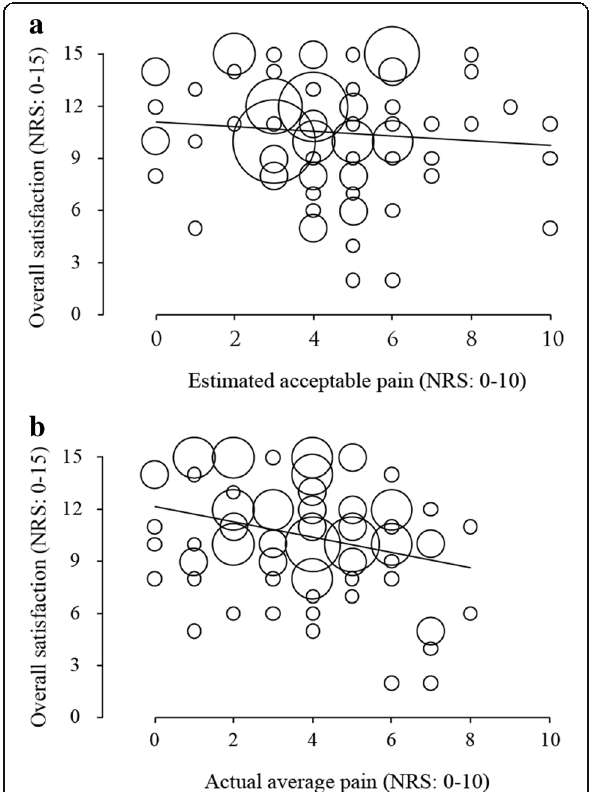
Fig. 2 Bubble plots showing the correlation between overall patient satisfaction for postoperative management and estimated acceptable pain intensity ( a ) or actual pain intensity ( b ). The degree of satisfaction and pain intensity were measured by numerical rating scale (NRS) 0 – 15 and 0 – 10, respectively. The lines represent the regression line. The circles are sized according to the number of the same values on the graph